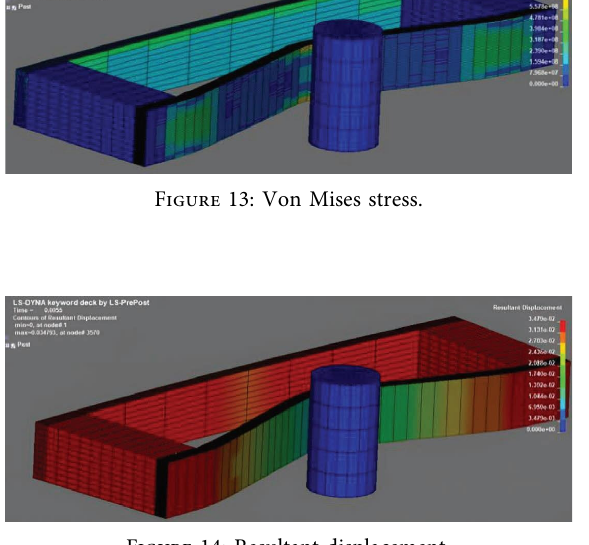
Figure 14: Resultant